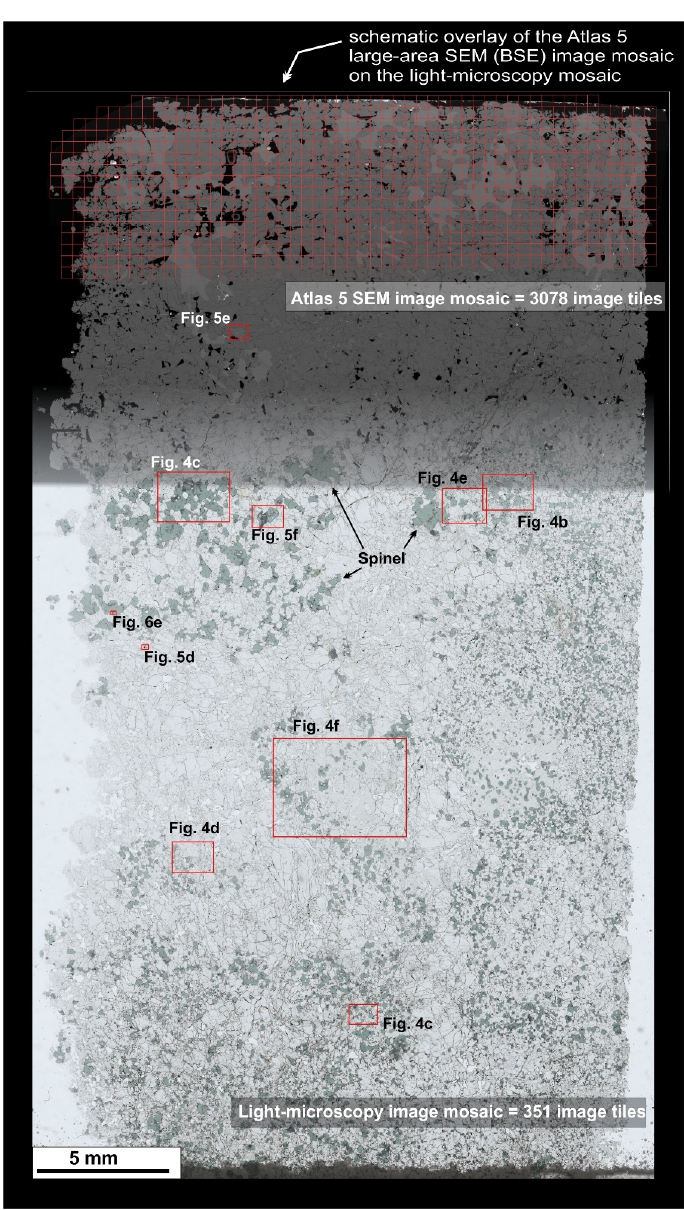
Figure 3. Large-area transmitted-light microscopy mosaic of the dunite, thin section “Parker Mine 6”.